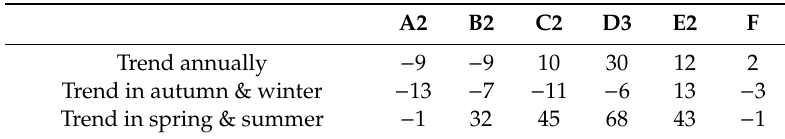
Table 2. Trends of velocities at 6 stakes along the central flow line of AL, in di ff erent seasons (unit: mm / a 2 ).